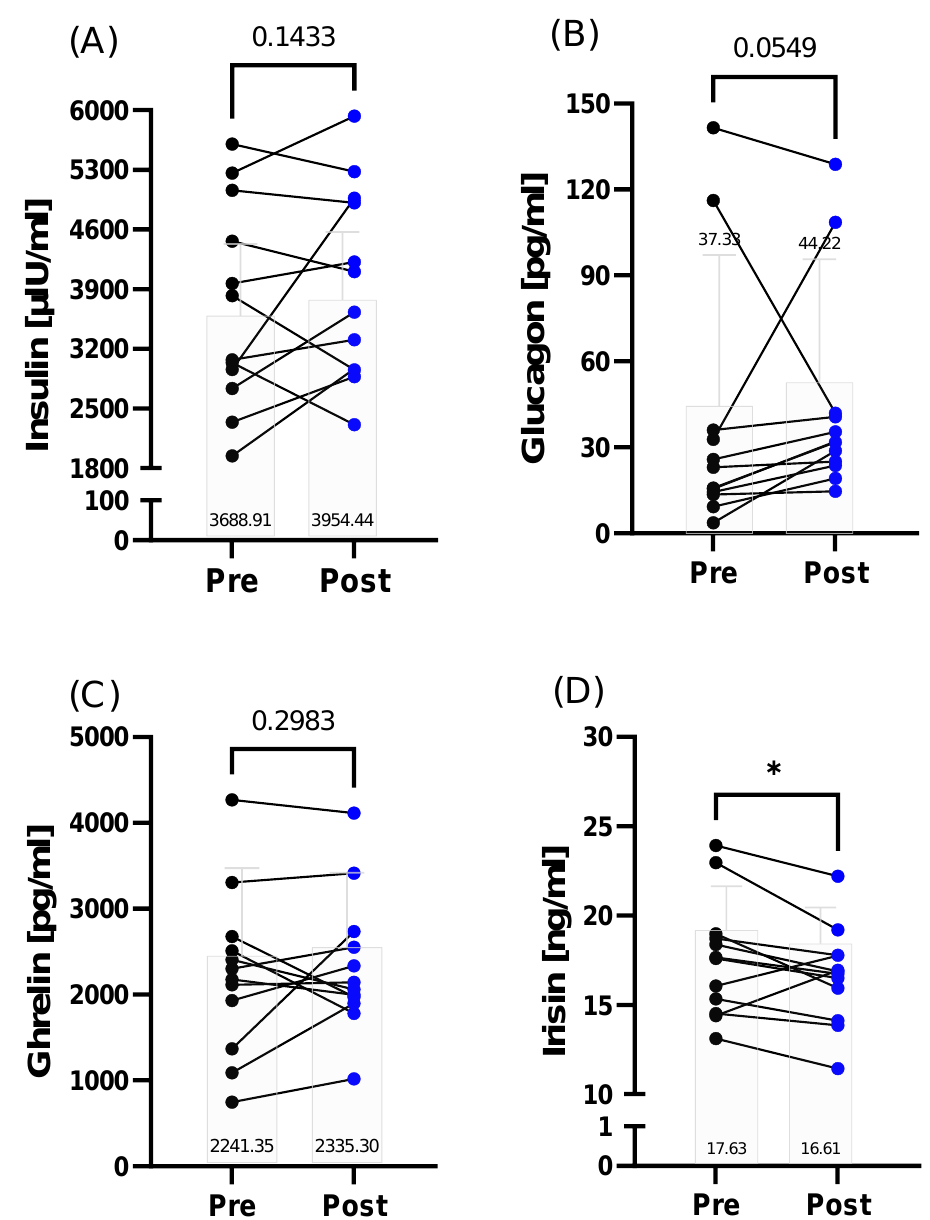
Figure 2. Energy- and nutrition-related variables in the 160.9/230 km race finishers ( n = 12) before (pre) and after (post) the 160.9/230 km competition. ( A ) Individual insulin concentrations showed high variation and mean values did not significantly change from pre to post ( B ). Glucagon con- centration was higher post-race. ( C ) Ghrelin values remained unchanged from pre to post, while ( D ) irisin levels decreased post-race. Presented are individual changes as well as mean number values. * p ≤